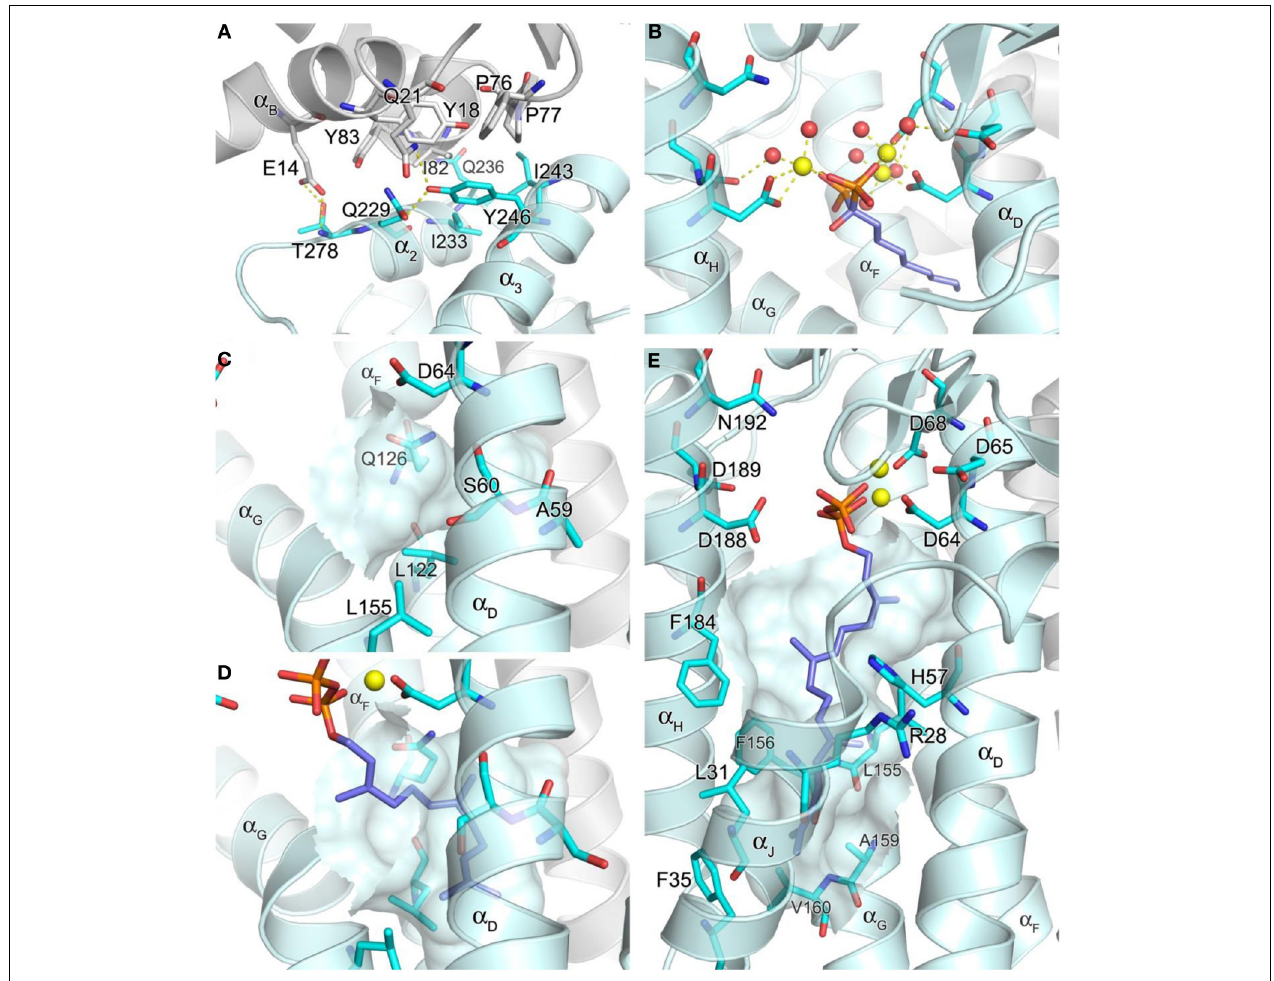
FIGURE 5 | Structure of geranylgeranyl pyrophosphate synthase. (A) The inter-dimer interface in hGGPPS (PDB ID: 2Q80). (B) Binding of a bisphosphonate with a long alkyl side chain to yeast GGPPS (PDB ID: 2Z4X); the trinuclear metal cluster is similar to that in Figure 4A . (C) The product chain elongation channel in hGGPPS.